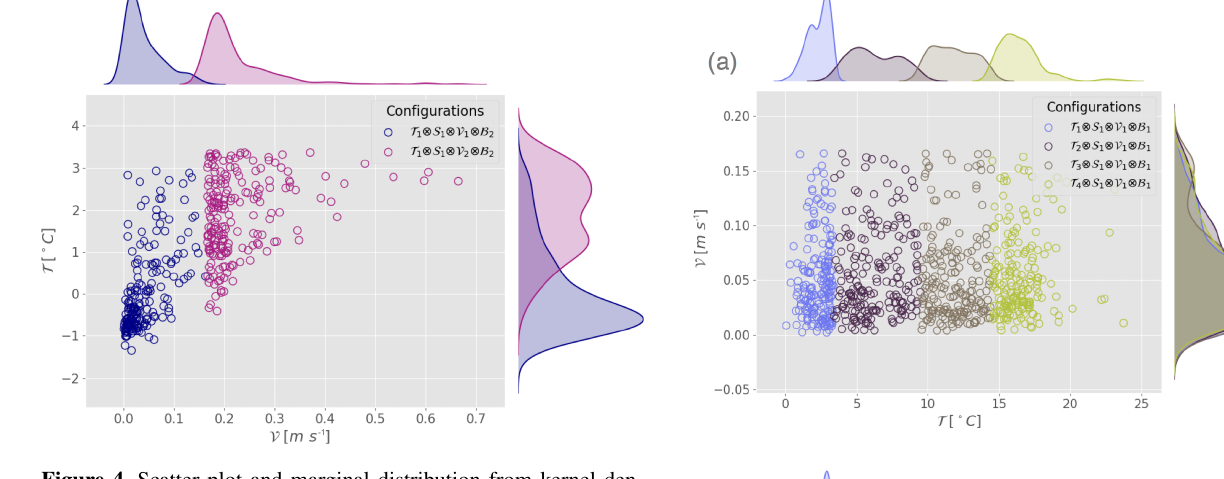
Figure 4. Scatter plot and marginal distribution from kernel den- sity estimation (Silverman, 2018) in the plane ( V , T ) of observation points used in Exp. 1 (cid:48) and Exp. 1 (cid:48)(cid:48) generated by random sampling in configurations C (cid:48) = T 1 ⊗ S 1 ⊗ V 1 ⊗ B 2 and C (cid:48)(cid:48) = T 1 ⊗ S 1 ⊗ V 2 ⊗ B 2 .